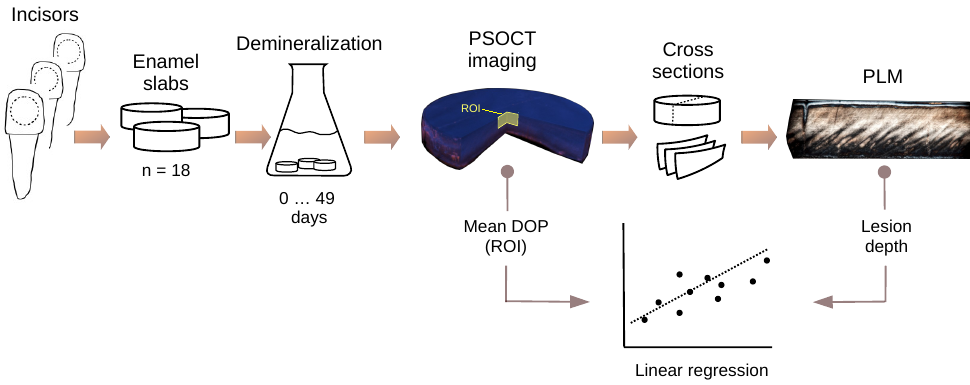
Figure 1. Workflow of the preparation and artificial demineralization of bovine enamel slabs, polarization-sensitive optical coherence tomography (PSOCT) imaging, cross-sectioning and polarized light microscopy (PLM) measurements, and data